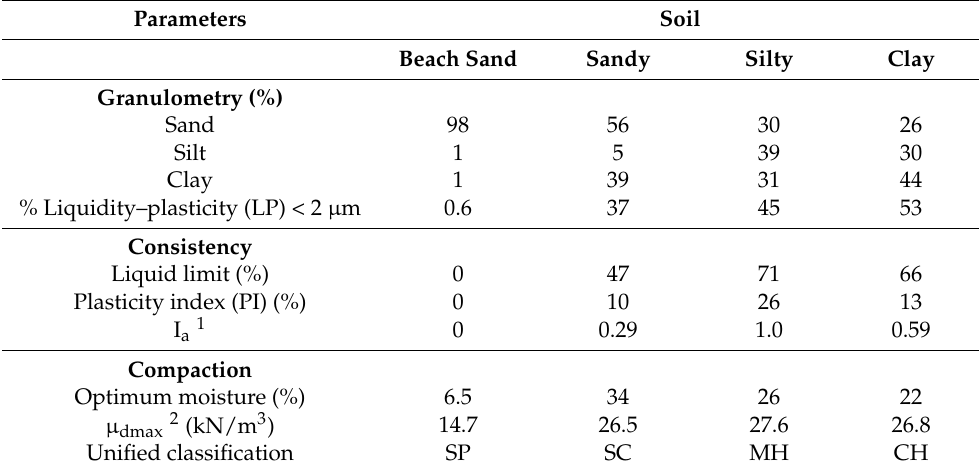
Table 5. Granulometry, consistency, and unified classification of soils. Parameters Soil Beach Sand Sandy Silty Clay Granulometry